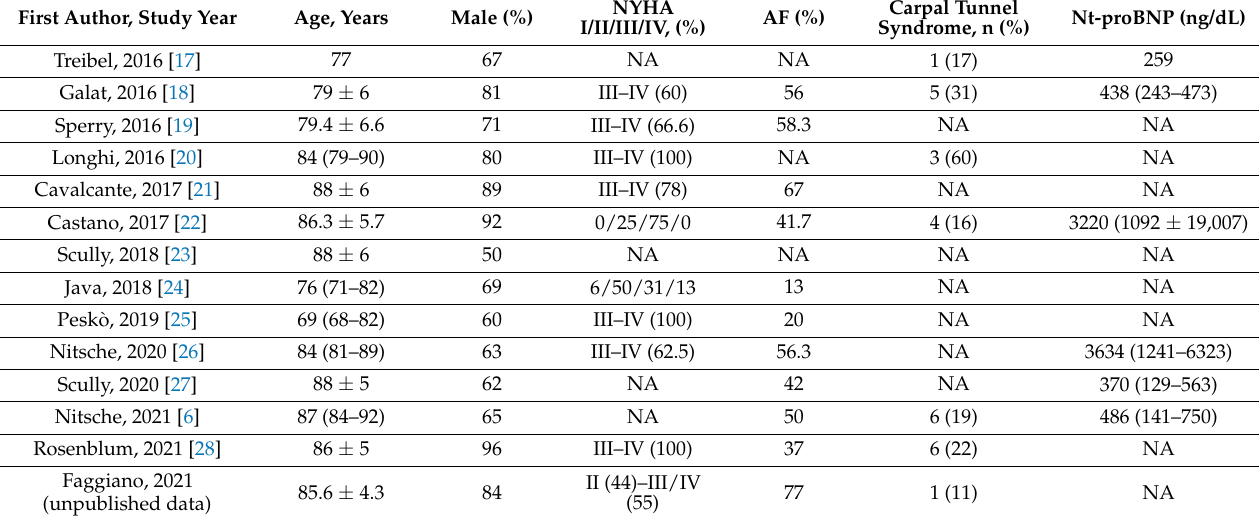
Table 3. Clinical characteristics and laboratory findings of AS-CA patients. See the text for